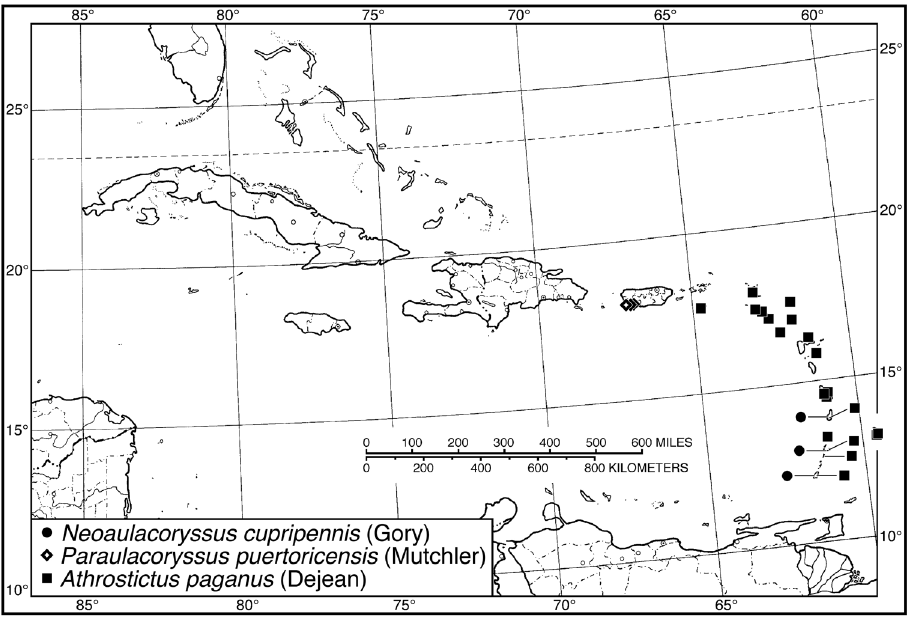
Figure 4. Map of West Indies showing known localities for species of Neoaulacoryssus Noonan, Paraula- coryssus , gen. n., and Athrostictus